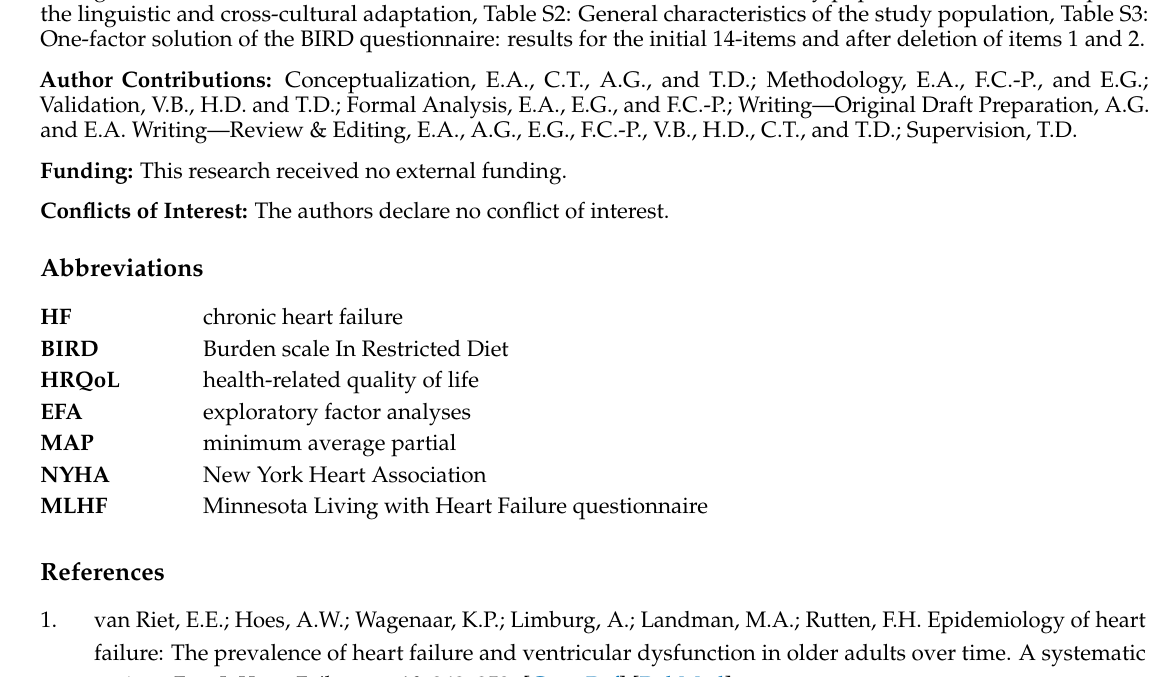
s1, Figure S1: Global 12-item BIRD score distribution in the validation study population, Table S1: Steps for the linguistic and cross-cultural adaptation, Table S2: General characteristics of the study population, Table S3: One-factor solution of the BIRD questionnaire: results for the initial 14-items and after deletion of items 1 and 2. Author Contributions: Conceptualization, E.A., C.T., A.G., and T.D.; Methodology, E.A., F.C.-P., and